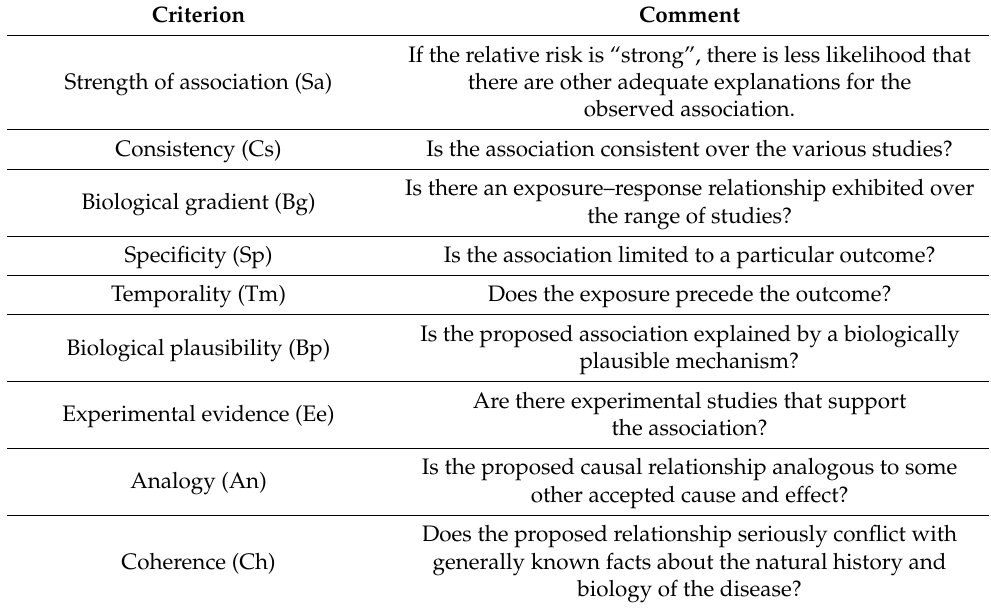
Table 2. The Austin Bradford Hill criteria for causality. Adapted from Hill [33], following [207]. Table 2 . The Austin Bradford Hill criteria for causality. Adapted from Hill [33] , following [207] . Criterion